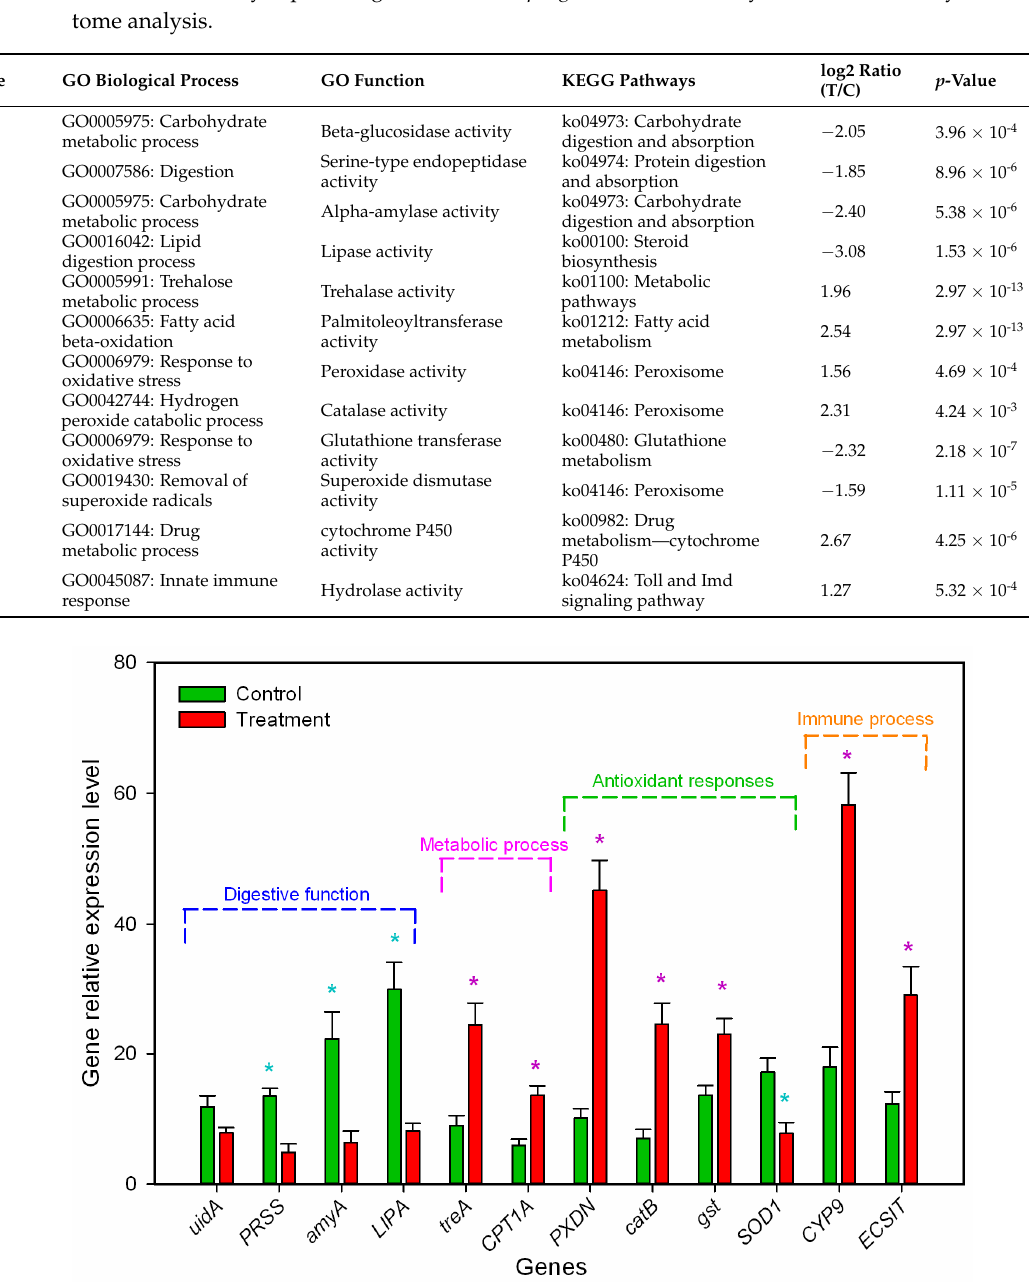
Figure 5. Real-time polymerase chain reaction (RT-PCR) analysis of gene expression in B. odoriphaga Figure 5. Real ‐ time polymerase chain reaction (RT ‐ PCR) analysis of gene expression in B. odoriphaga larvae after infection with M. hiemalis spores. RT-PCR data calculated with the 2 − ∆∆ Ct method. The larvae after infection with M. hiemalis spores. RT ‐ PCR data calculated with the 2 −∆∆ Ct method. The value of the relative expression level on the y ‐ axis was calculated according to log(2 −∆∆ Ct ). *, p < 0.05, value of the relative expression level on the y-axis was calculated according to log(2 − ∆∆ Ct ). *, p < 0.05, as determined by one ‐ way analysis of variance (ANOVA). as determined by one-way analysis of variance Table 3. Differently expressed genes of B. odoriphaga larvae infected by M. hiemalis BO ‐ 1 by tran ‐ scriptome analysis.